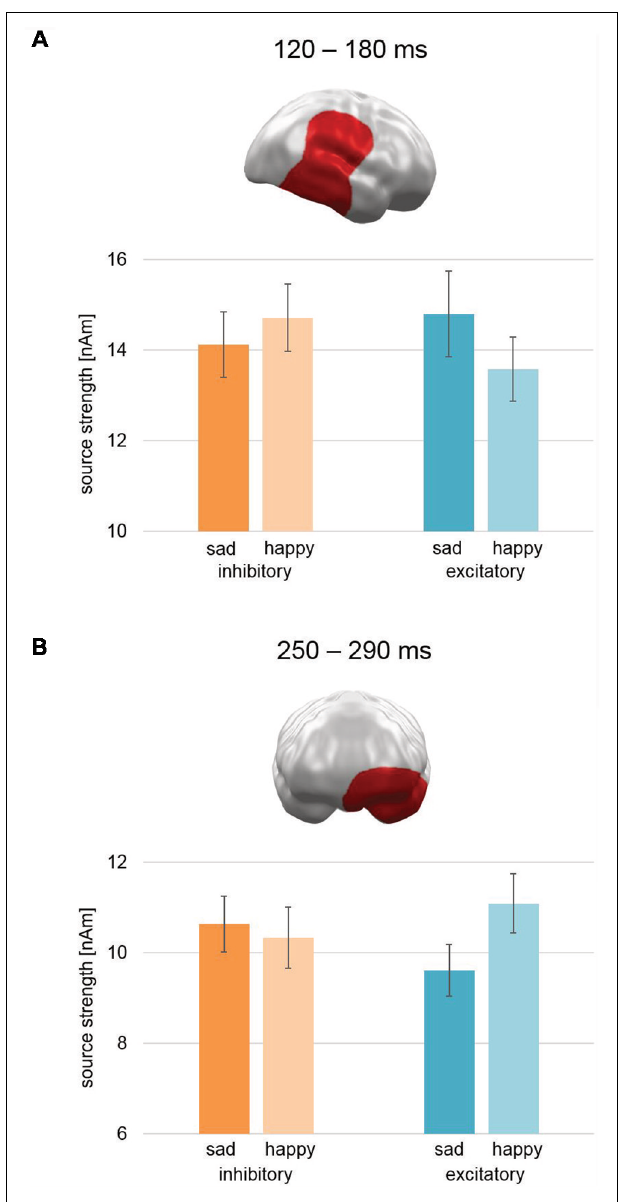
FIGURE 5 | Spatio-temporal clusters with significant interactions of Stimulation × Valence. (A) An early to mid-latency cluster spanning right temporal, parietal, and frontal areas—including temporal parietal junction and superior temporal cortex—showed an activation pattern opposite to our hypothesis: after excitatory vmPFC-tDCS, sad faces showed relatively higher activation than happy faces and vice versa after inhibitory vmPFC-tDCS. (B) A mid-latency cluster at left orbitofrontal and temporal pole areas revealed an effect consistent with our hypothesis: after excitatory vmPFC-tDCS, happy faces showed increased activation in comparison to sad faces and vice versa after inhibitory vmPFC-tDCS. Bar graph insets indicate standard error of the mean ( ± SEM).